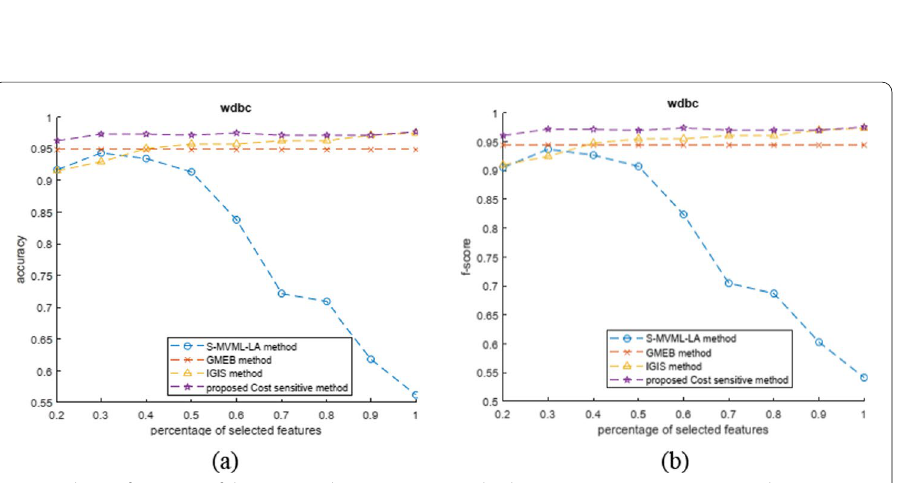
Fig. 7 The performance of the proposed cost sensitive method, S-MVML-LA [15], GMEB [10] and IGIS [20] versus the changes in percentage of selected features numbers on the WDBC dataset. a Accuracy, b